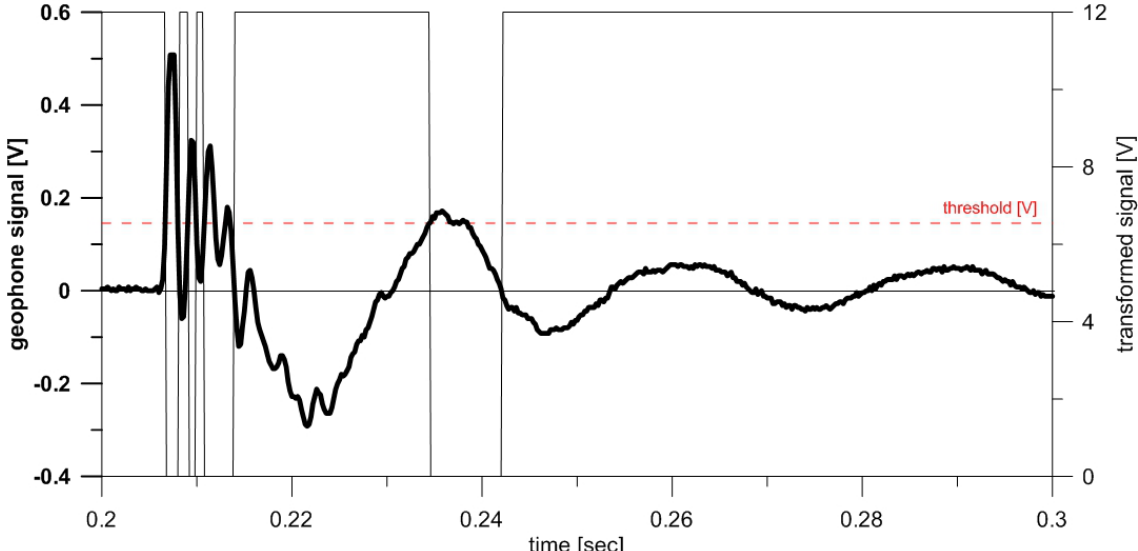
Figure 3. Transformation of the geophone signal (thick line) into a pulse signal (thin line) by the signal conditioner using a previously defined threshold value (dashed red